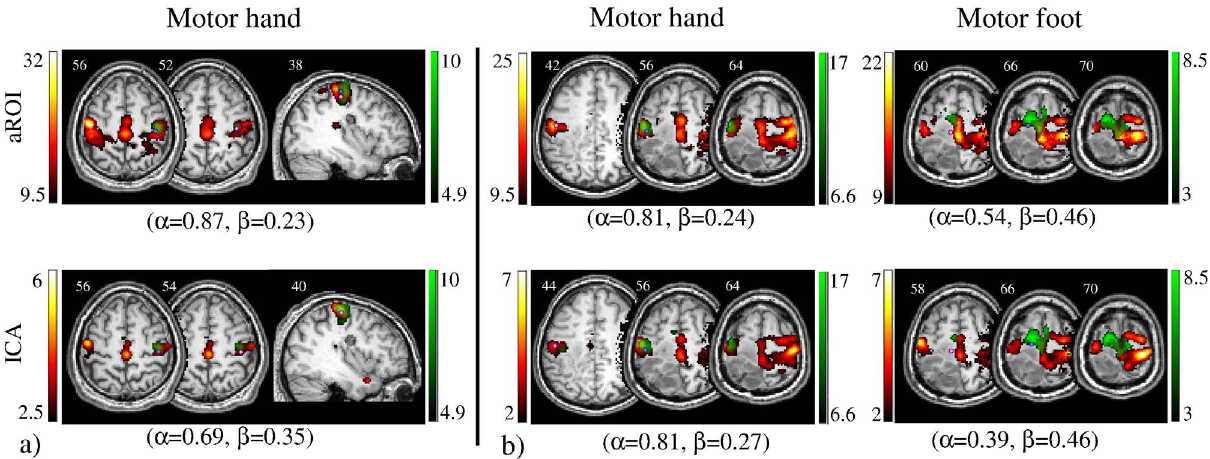
Figure 1. Concordance between task-based (tb-fMRI, in green) and resting-state (rs-fMRI, in red) fMRI maps computed with aROI (top row) and ICA (bottom row). Overlap sensitivity ( a ) and specificity ( b ) of rs-fMRI with respect to tb-fMRI, obtained with operator-dependent thresholds, are reported. Light blue circle represents the Centre of Mass (CoM) of tb-fMRI, and pink circle represents the CoM of rs-fMRI. Images are shown in neurological convention (left is left) and MNI coordinates are reported on top of each slice. a) For Case 5 concordance was optimal in terms of overlap values and CoM distance. b) For Case 9 the aROI and ICA maps were extremely similar to each other, in particular for the hand area. However, the aROI was more useful than ICA to localize the foot area as it included the paracentral lobule.